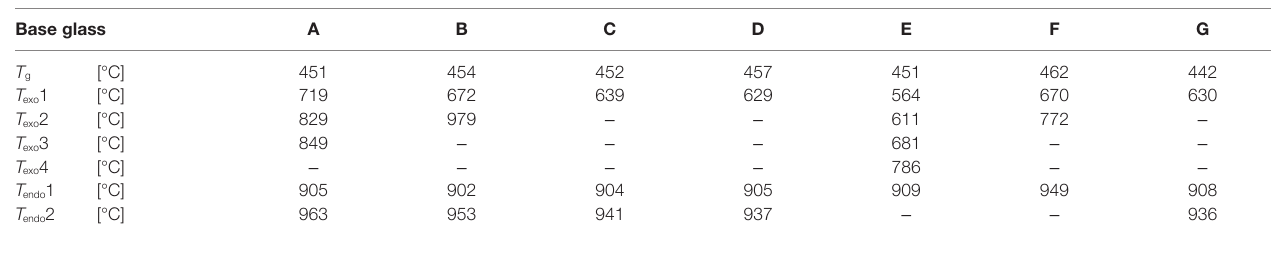
TaBle 2 | Thermal analysis of the base glasses by means of Dsc.